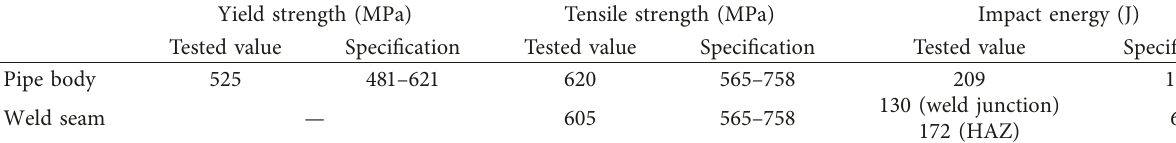
Table 2: Mechanical properties of the X70 HFW pipes.